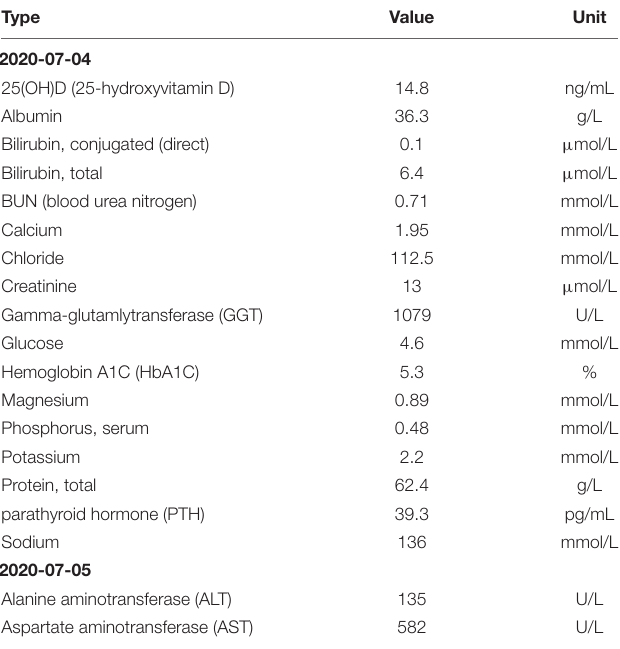
TABLE 1 | Laboratory findings of the patient with Fanconi-Bickel syndrome